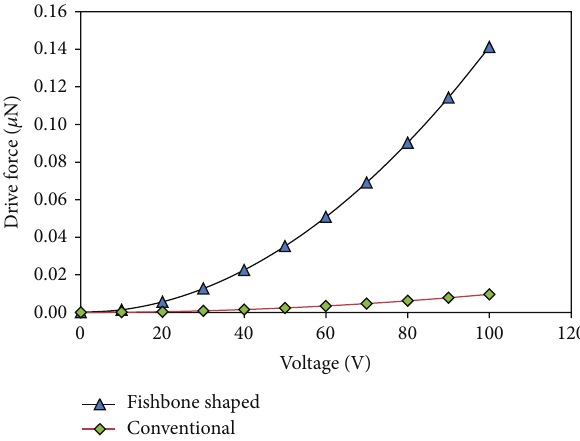
Figure 8: Electrostatic force (drive force) as a function of voltage, exerted on the comb fingers in the 𝑥 -direction for both single unit of straight sided comb finger and fishbone shaped comb driver.